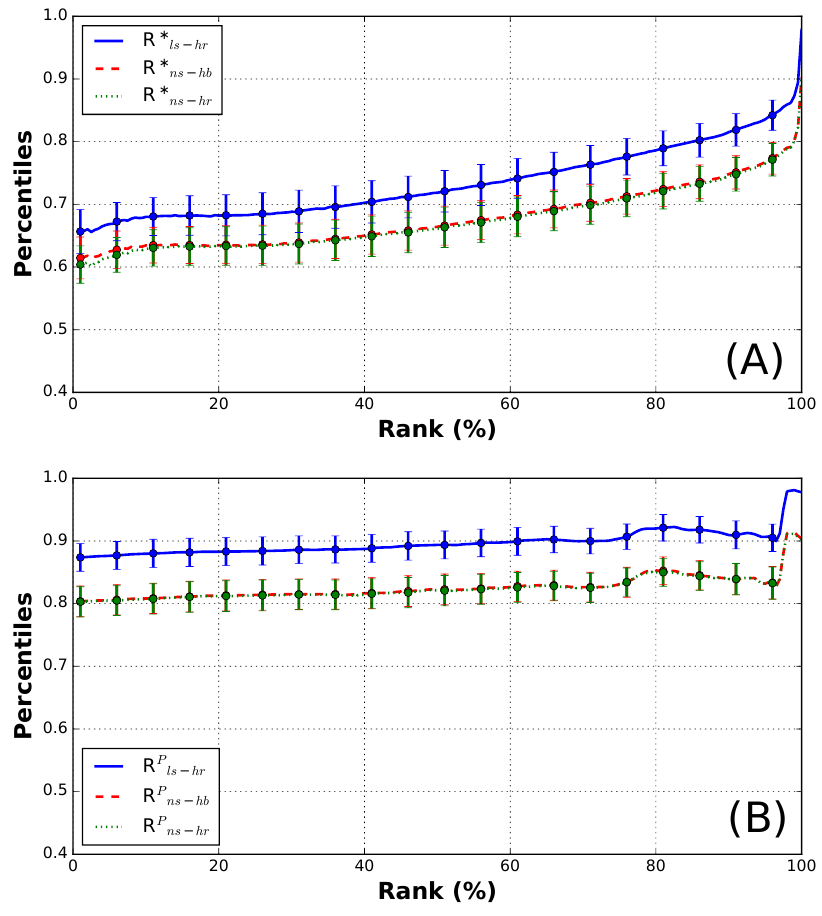
Figure 4. Wave runup. ( A ): percentiles of the EPDF of R ∗ (ratio of the percentiles of the EPDFs of the estimated whole 2% exceedance wave runup time series, i.e., R 2 − ns − hb , R 2 − ns − hr and R 2 − ls − hr , and the reference value, i.e., R 2 − ls − hb ); ( B ): percentiles of the EPDF of R P (ratio of the percentiles of the EPDFs of the estimated maximum 2% exceedance wave runup of sea storms, i.e., R P